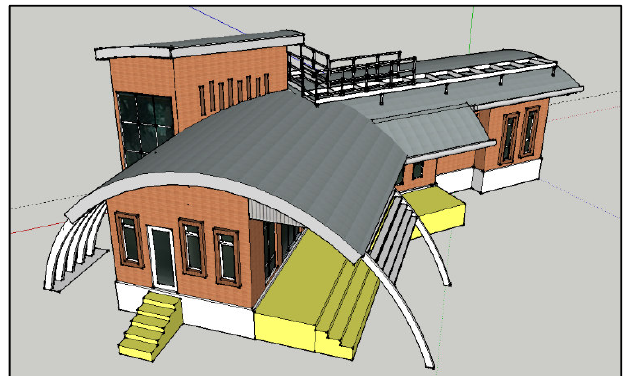
Figure 17. The 3D model of Eco-home building generate using Sketch Up software.